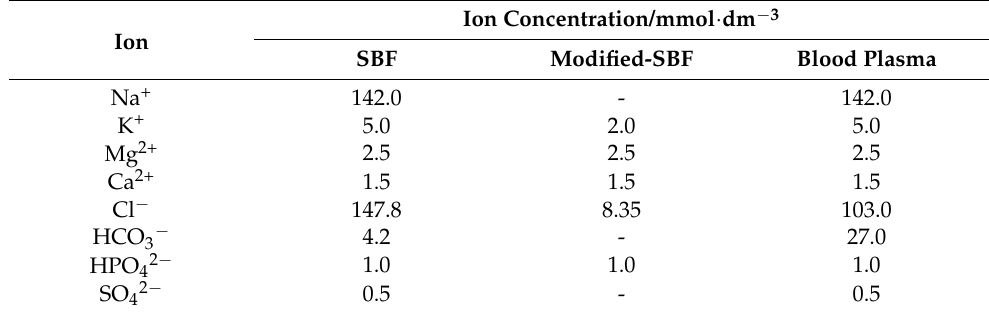
Table 1. Inorganic ion concentrations in SBF [17], modified-SBF, and human blood plasma [17].